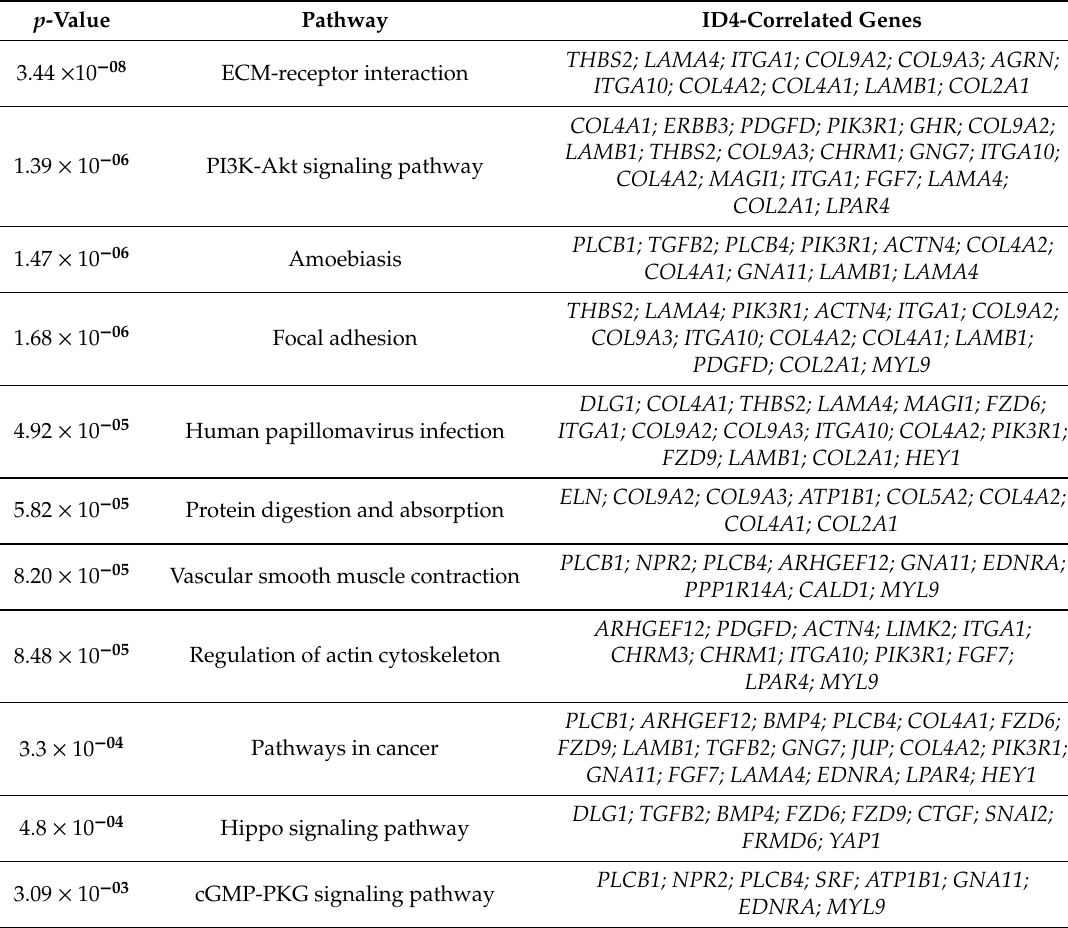
Table 1. Pathways enriched among the genes positively correlated to ID4 in both the E-GEOD-18295 dataset and in basal-like breast cancers of the TCGA cohort. Analysis was performed using ConsensusPathDB, interrogating the KEGG pathway database (cuto ff , n = 8